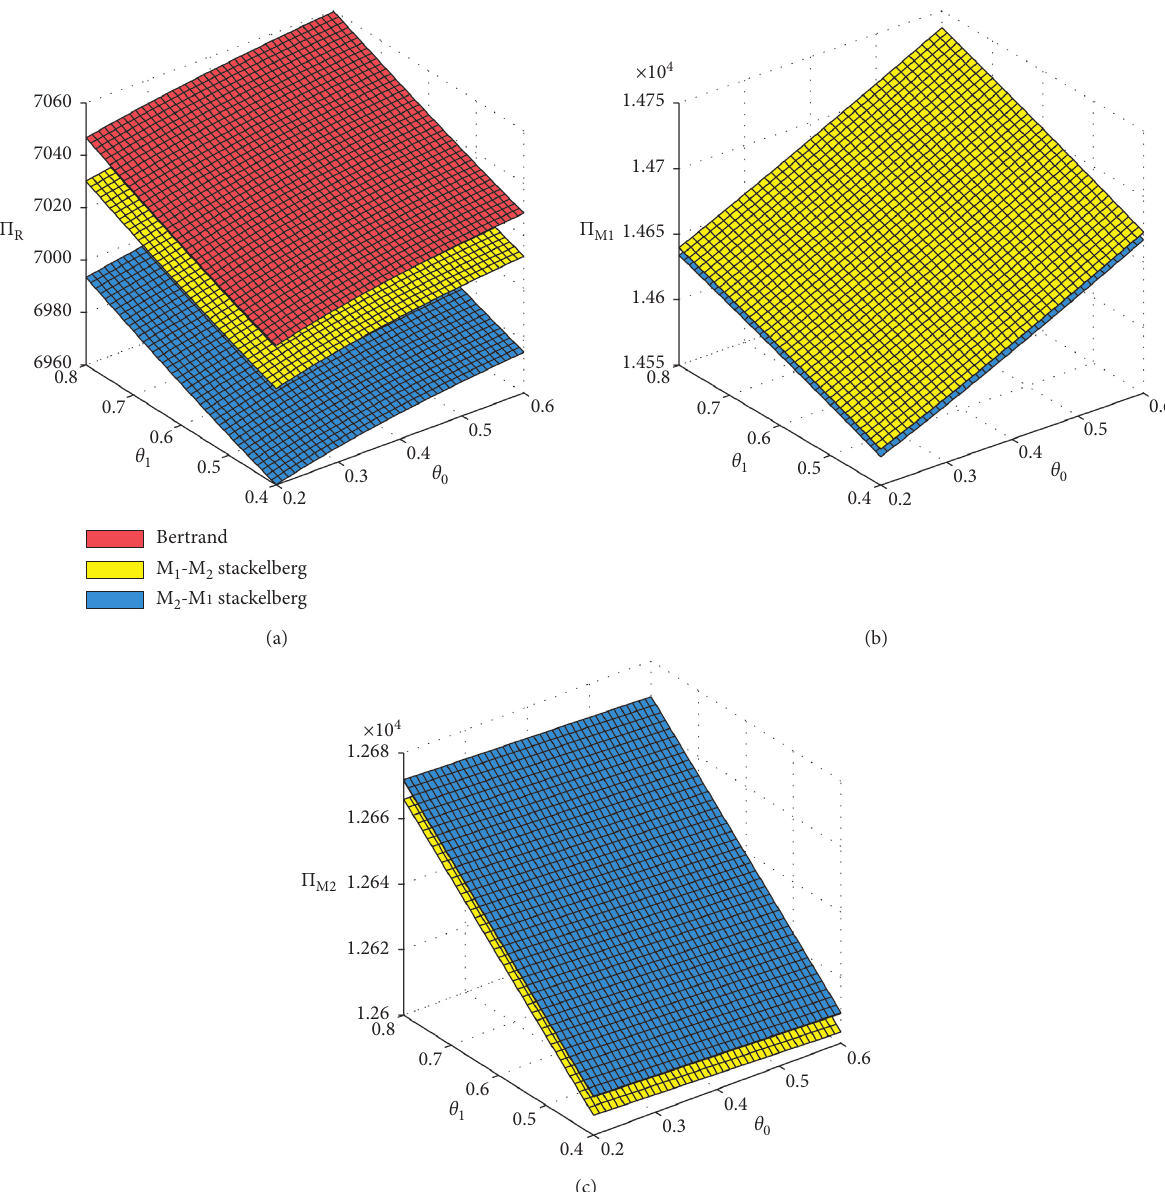
Figure 5: Influence of θ ( i � 1 , 2 ) on profit functions under different i